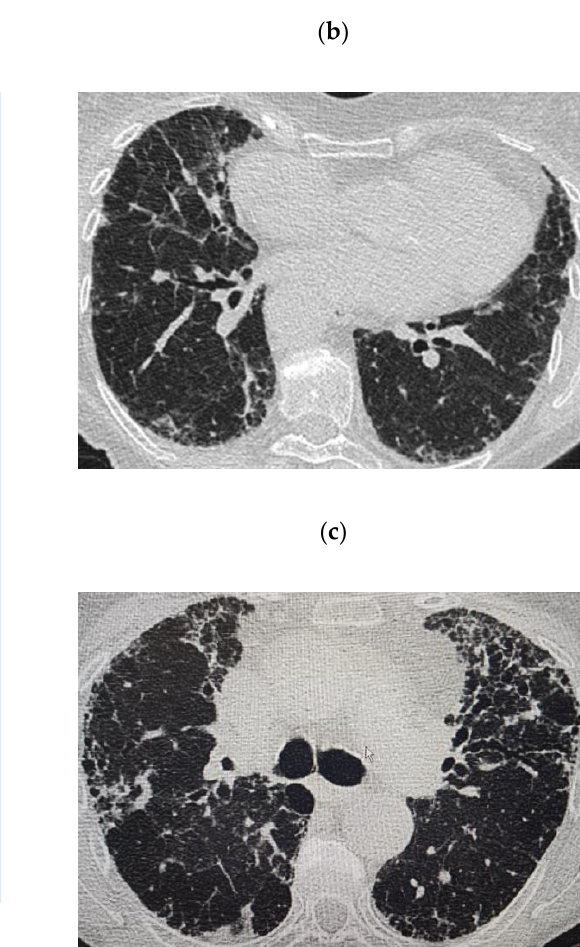
Figure 4. Changes in regional lung ventilation under increasing PEEP in IPF patient #14. Left panel ( a ): Spatial distribution of TID, SURF, dTID, dEELI in the EI tomogram at a PEEP of 0 (left), 3 (2nd left), 6 (3rd from left) and 9 levels (right column). The lowest panel indicates the intratidal gas distribution (ITV) for four anatomical areas during one respiration. Given are the distribution of ventilation into the ventral (V), dorsal (D), medio-ventral (MV) and medio-dorsal (MD) regions of the lung. The X scale (1–5) shows the entire inspiration, divided into 5 steps. Right panel ( b , c ): The respective high resolution CT picture corresponding to the ROI of EIT measurement is shown. Abbreviations: CG—center of gravity of ventilation distribution; dEELI—difference of end-expiratory lung impedance over time; ITV—intratidal gas distribution, PEEP— positive end-expiratory pressure; SURF—surface of ventilated areas; TID—tidal impedance distribution; dTID—differ- ence of TID over time.